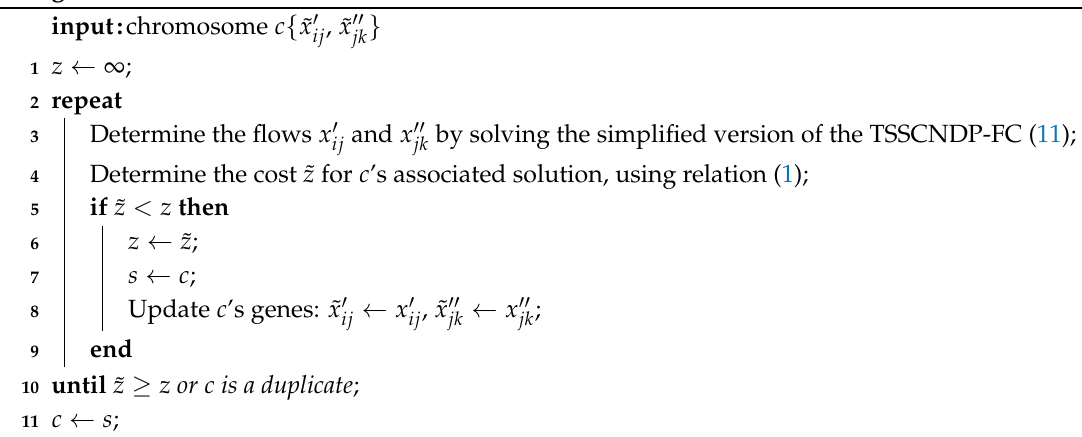
Algorithm 1: Procedure Chromosome